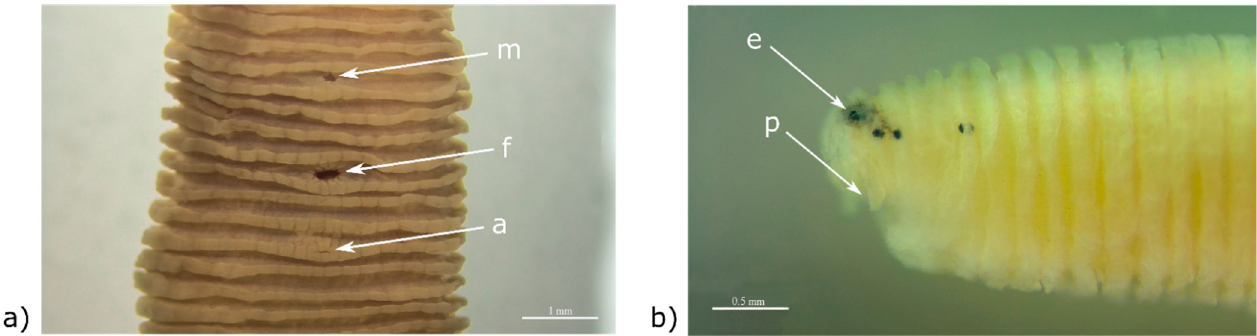
Figure 3. ( a ) Gonopores in the Dinaric land leech ( Xerobdella anulata ) from Croatia, ( b ) lateral view of the anterior body part. Legend: m—male gonopore, f—female gonopore, a—accessory female gonopore, e—eyespot, p—oral palp.